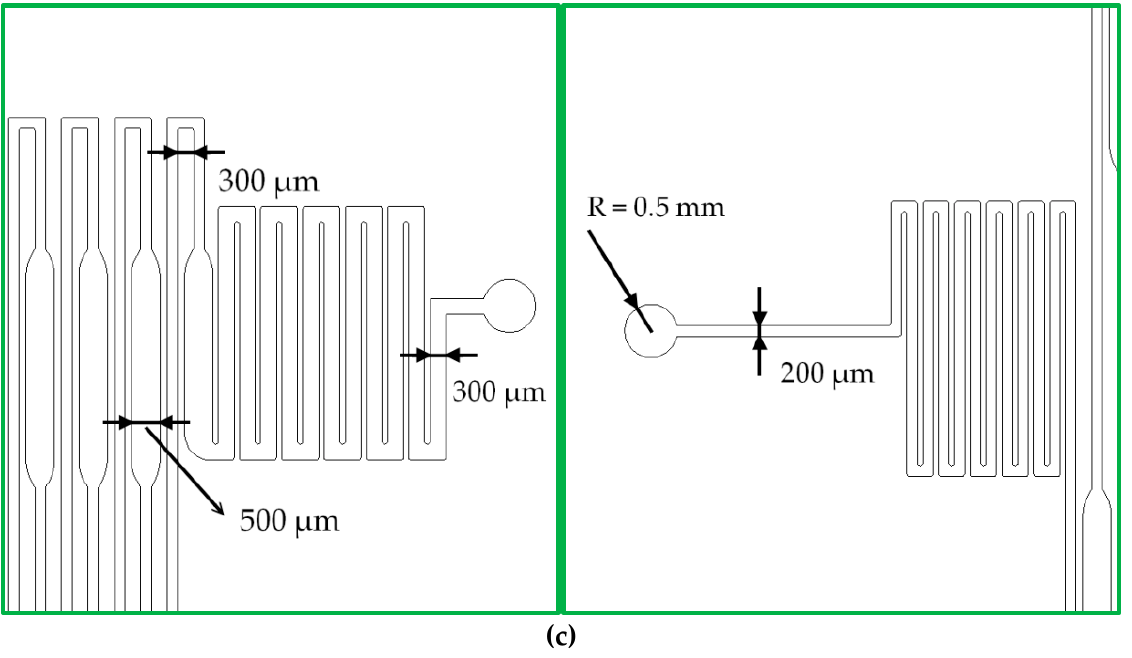
Figure 2. ( a ) A photographic image of the CFPCR chip comprising a PDMS layer and a glass slide. ( b ) A schematic diagram of the 30-loop channel. ( c ) The pre-denaturation part (left) and the pro-extension part (right).